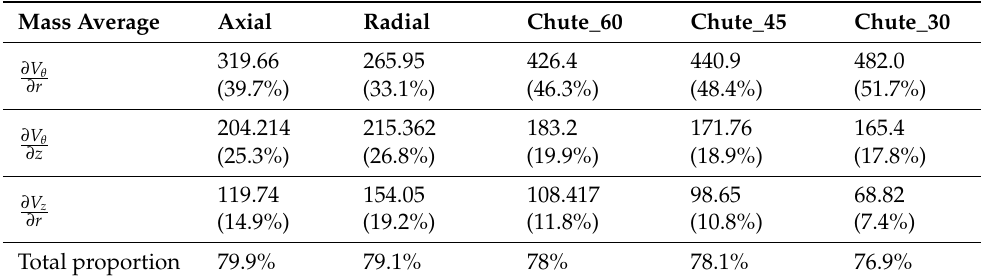
Table 7. Velocity gradient for a variety of sealing